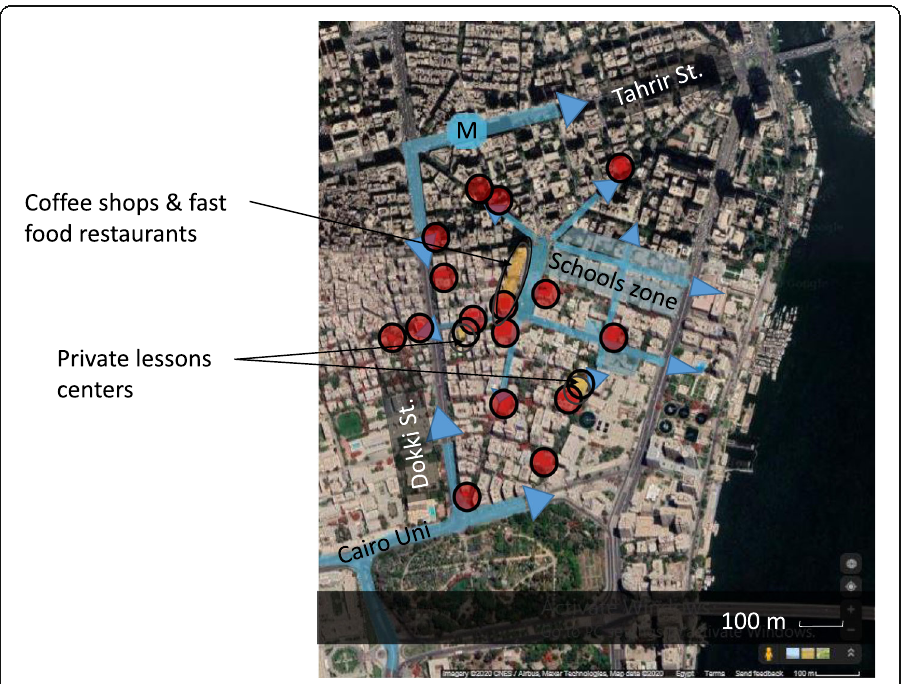
Fig. 5 Youth flow to co-working spaces and presence from universities, schools, public transit, and private lesson centers in Mesaha area in Dokki (largest concentration of co-working spaces). Map source https:// www.google.com/maps , elaboration by authors